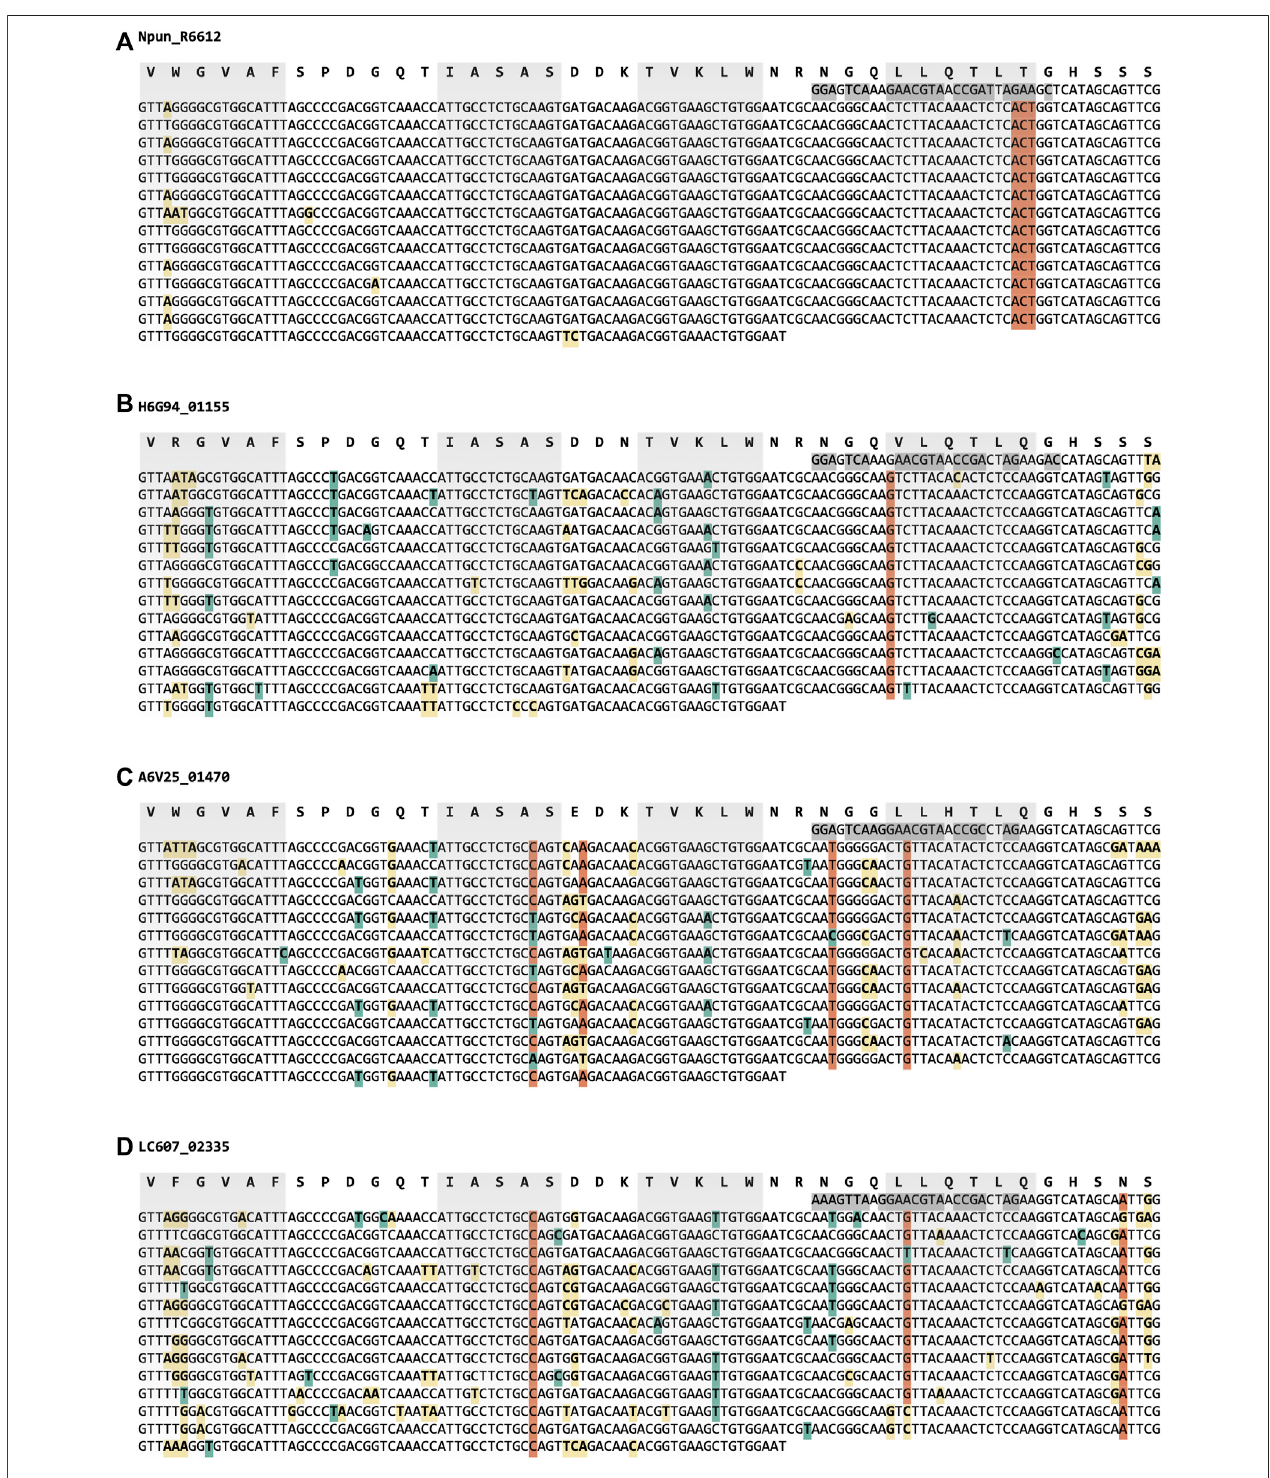
FIGURE 2 | Synonymous and non-synonymous mutations in the nucleotide sequence of four closely related WRAP domains ( ≥ 80% pairwise sequence identity, Supplementary Figure S3 ). Synonymous mutations relative to the majority rule consensus of the respective β -propeller are highlighted in teal, and non-synonymous onesinyellow.Positionswhereanucleotideispresentinatleasttwothirdsofthebladesofone β -propeller,but differentfromtheequivalentnucleotidesinatleasttwoof